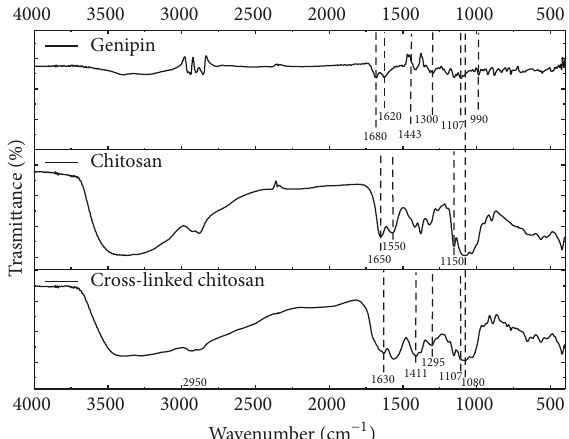
Figure 5: The FTIR spectra of genipin and CS before cross-linking with genipin and CS after